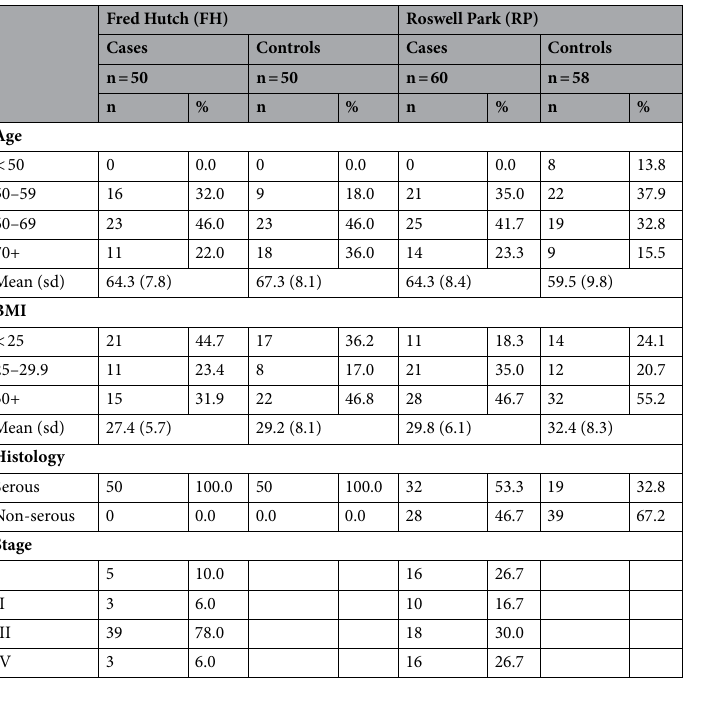
Table 1. Study participant and tumor